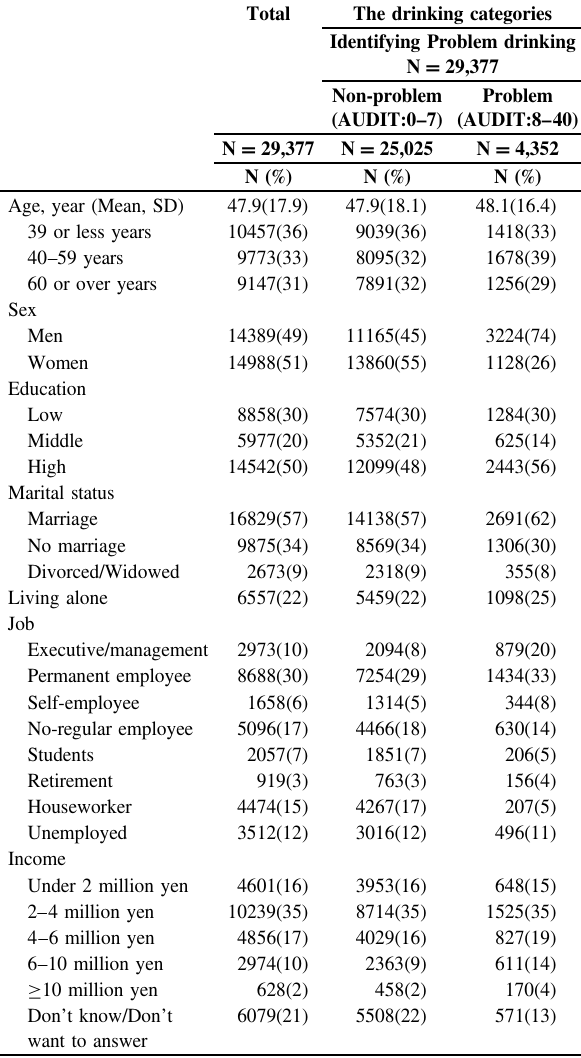
Table 1 The characteristics of participants according to sociode-